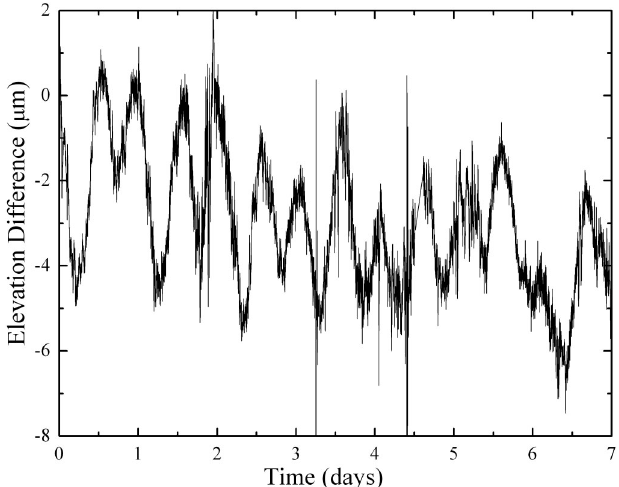
FIG. 34. (Color) Diffusion coefficient A calculated for all pos- sible combination of the probes distanced by L from 15 to 135 m from 1 month data records in MI8 tunnel [46].